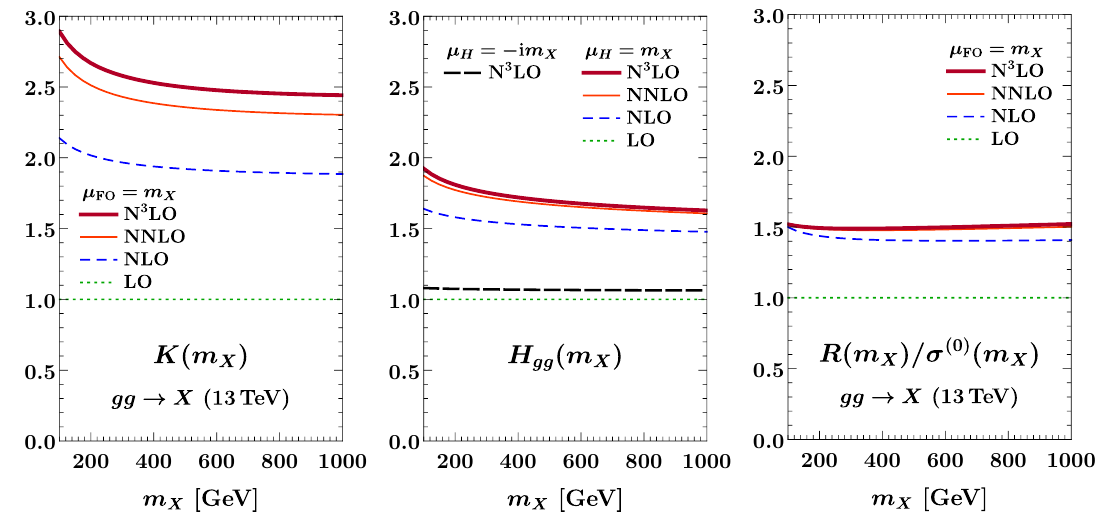
Figure 2 . Illustration of the (cid:12)xed-order perturbative series for gg ! X at (cid:22) FO = m X for the inclusive K -factor (left), the hard function H gg at (cid:22) H = m X (center), and the normalized remainder R=(cid:27) (0) (right). The middle panel also shows the N 3 LO hard function H gg at (cid:22) H = (cid:0) i m X (black long dashed), for which it contains no timelike